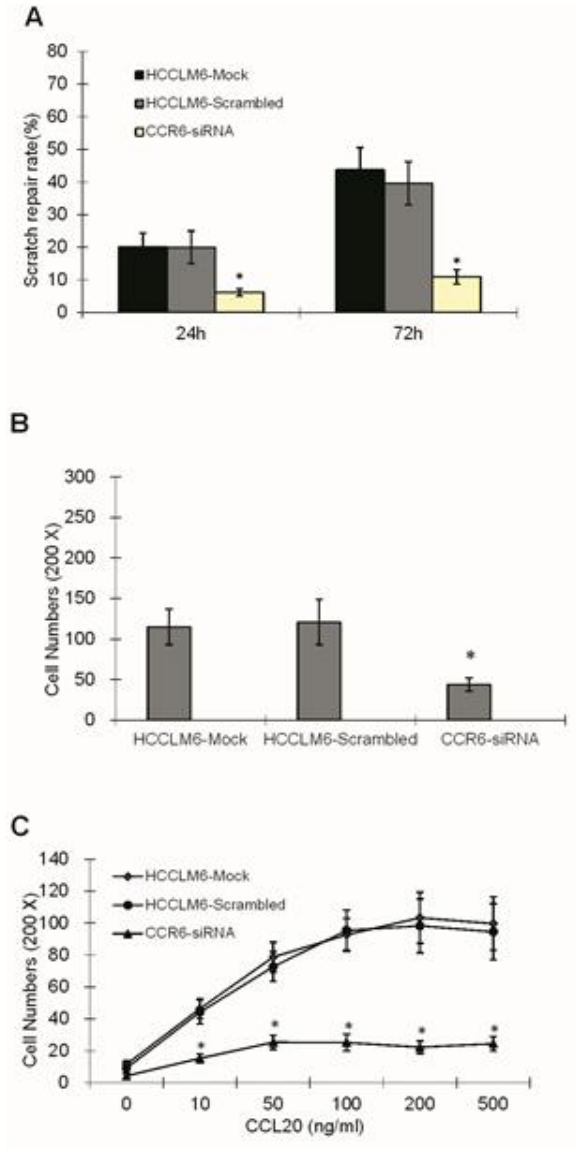
Figure 5. The scratch repair rates ( A ); invasive ability ( B ) and chemotaxis of cells ( C ) in different groups. * p < 0.05 compared with the control groups.